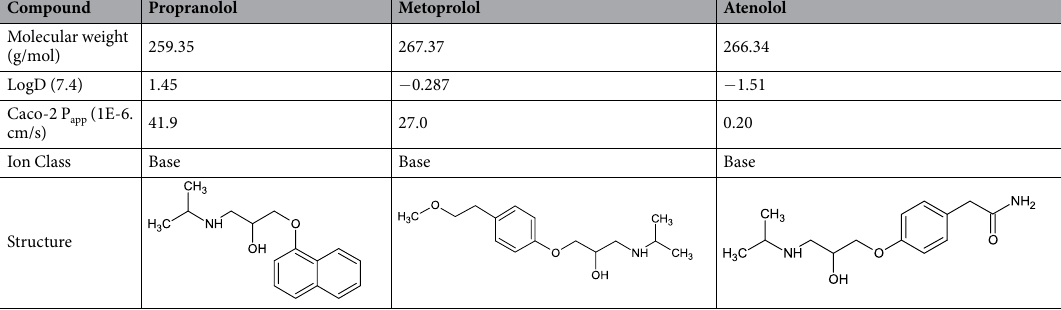
Table 1. Physicochemical Data, MW, and log D (octanol/water, pH 7.4), and Caco-2 permeability for the three tested drugs (from refs 1, 15 and